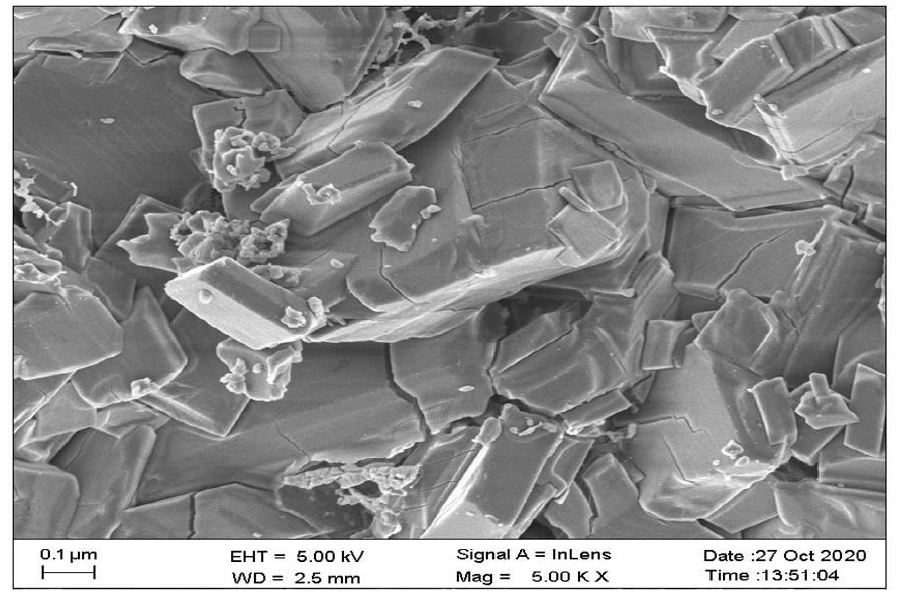
Figure 8. FE-SEM photographs optimized telmisartan-maleic acid cocrystals (TMA 1:2 ).